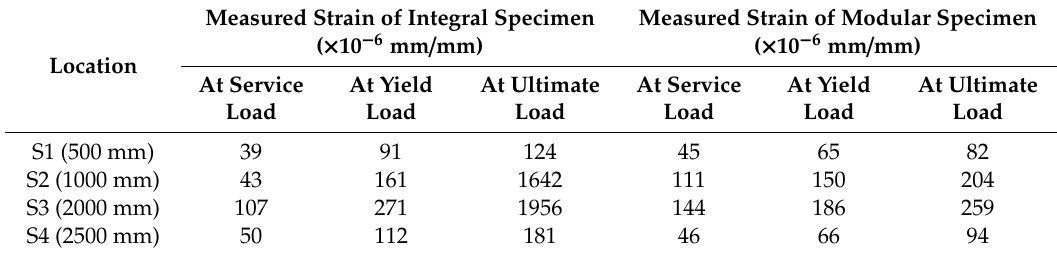
Figure 6. Reinforcement strain of the integral and modular specimens: ( a ) S1; ( b ) S2; ( c ) S3; ( d ) S4. Table 3. Measured strain at location S1, S2, S3, and S4 of integral and modular specimen.